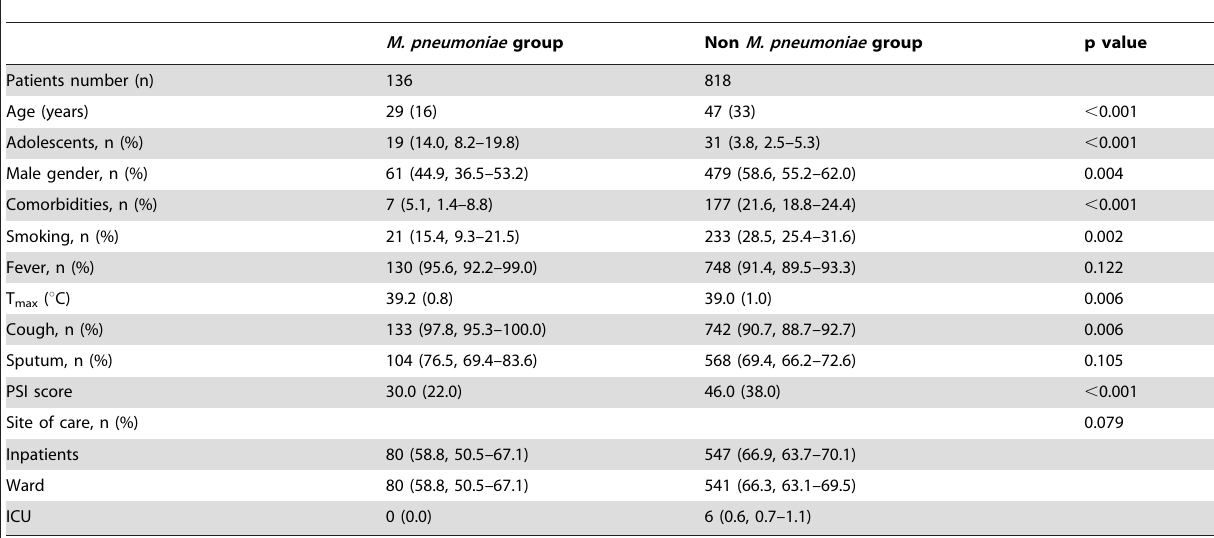
Table 1. Comparison between patients with M. pneumoniae pneumonia and those without.